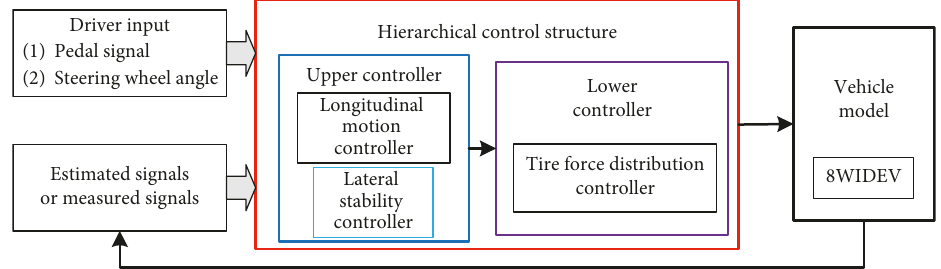
Figure 7: Traditional typical control structure for the